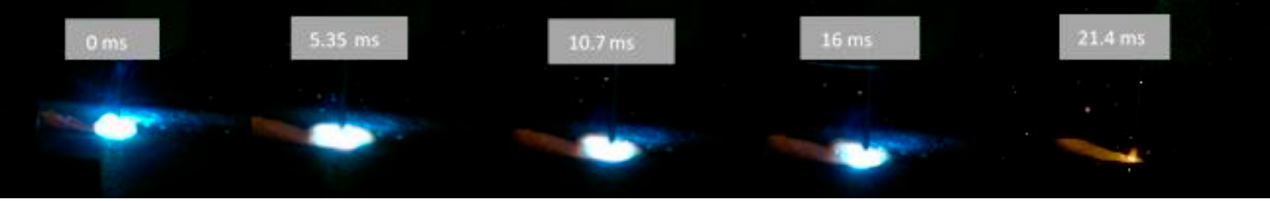
Figure 2. The arc appearance, labeled with the timing from the droplet initiation to detachment, for the ternary